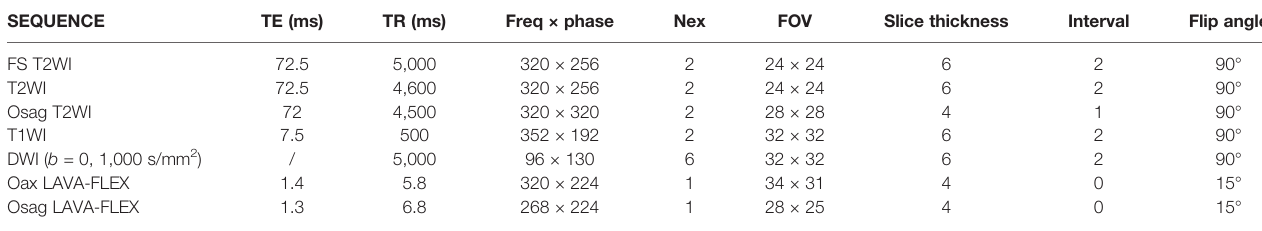
TABLE 1 | Partial list of MRI